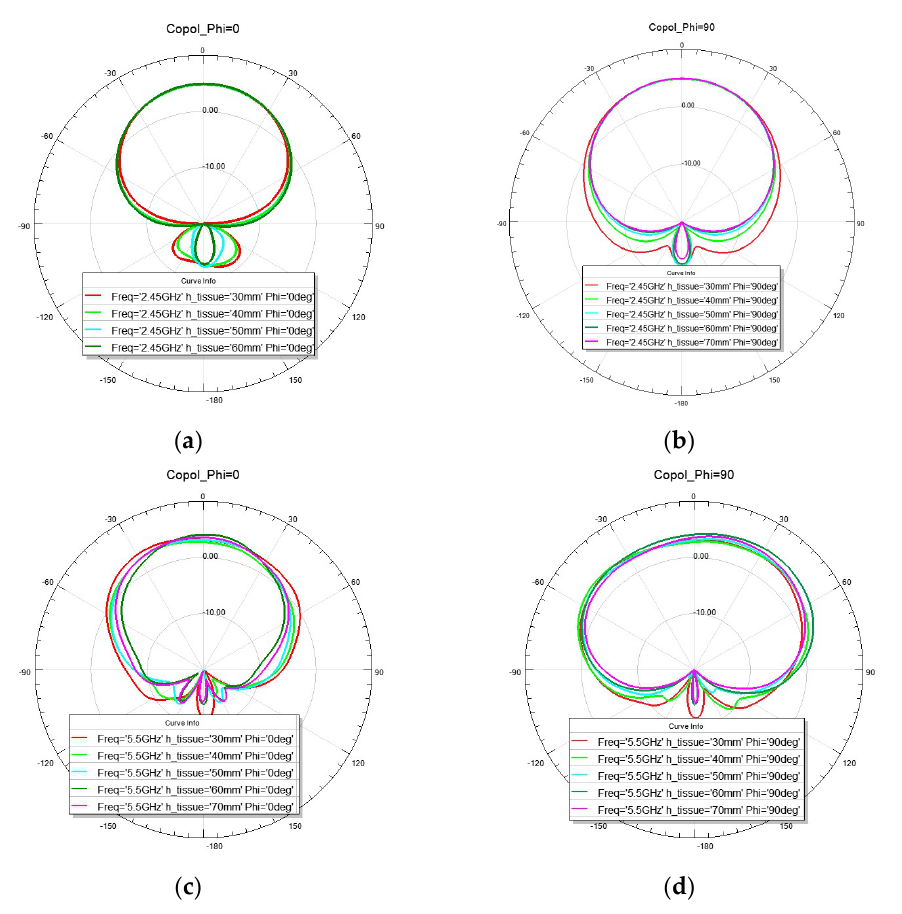
Figure 8. Simulated co-polarization radiation patterns for bending condition : ( a ) frequency 2.45 GHz phi = 0 degrees; ( b ) frequency 2.45 GHz phi = 90 degrees; ( c ) frequency 5.5 GHz phi = 0 degrees; ( d ) frequency 5.5 GHz p ℎ𝑖 = 90 degrees .